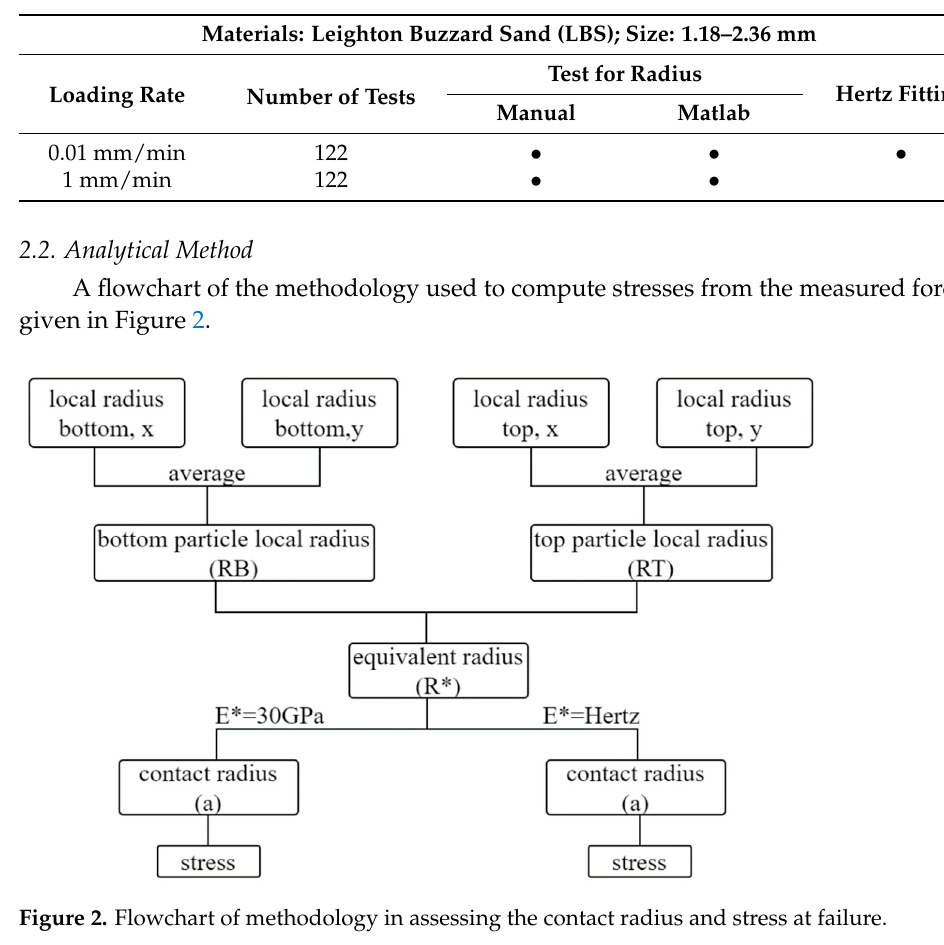
Table 1. Summary of tests and respective analysis.